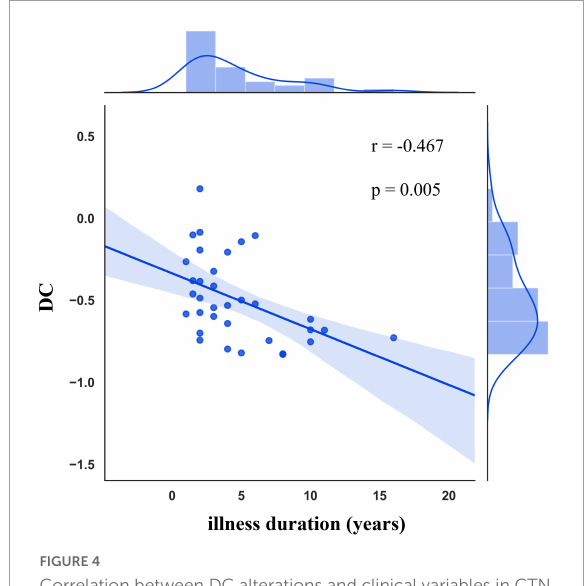
FIGURE4 Correlation between DC alterations and clinical variables in CTN patients. DC in the left MCC was negatively associated with the illness duration. DC, degree centrality; CTN, classic trigeminal neuralgia; MCC, midcingulate